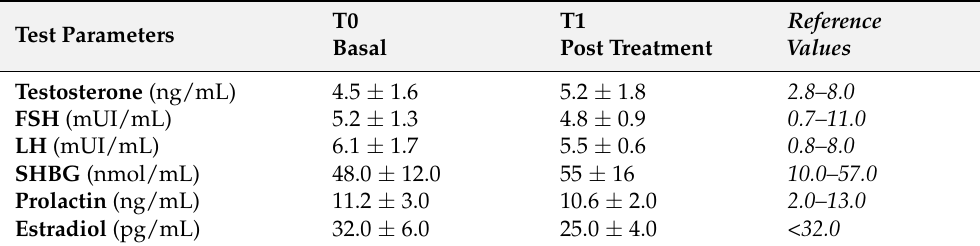
Table 3. Evaluation of the hormone levels before treatment with the nutraceutical preparation (T0) and after three months of administration (T1).